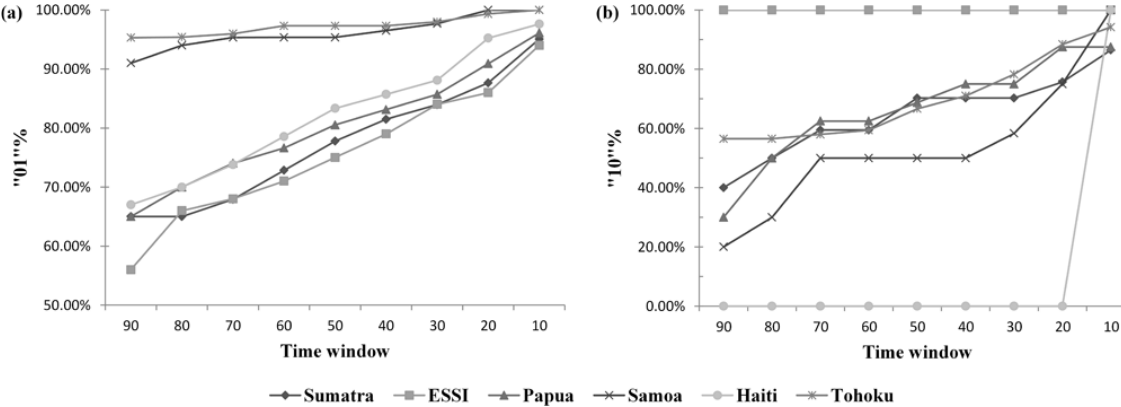
Fig. 4. The relationship between the time window and percentages of “01” and “10”